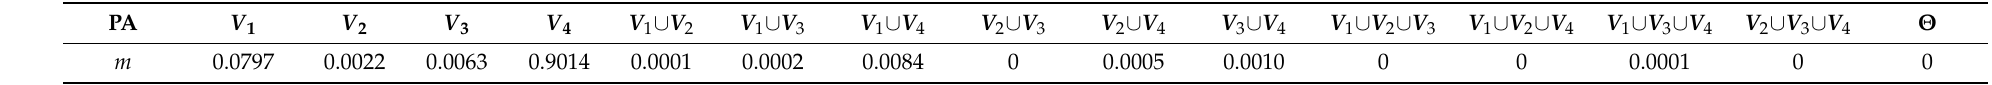
Table 10. The result of second-level fusion for an image of an oblique crack based on OAR